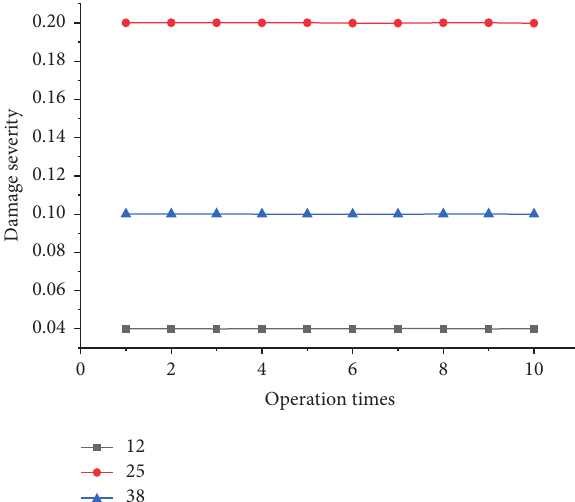
Figure 10: Damage severity identification of IPSO.